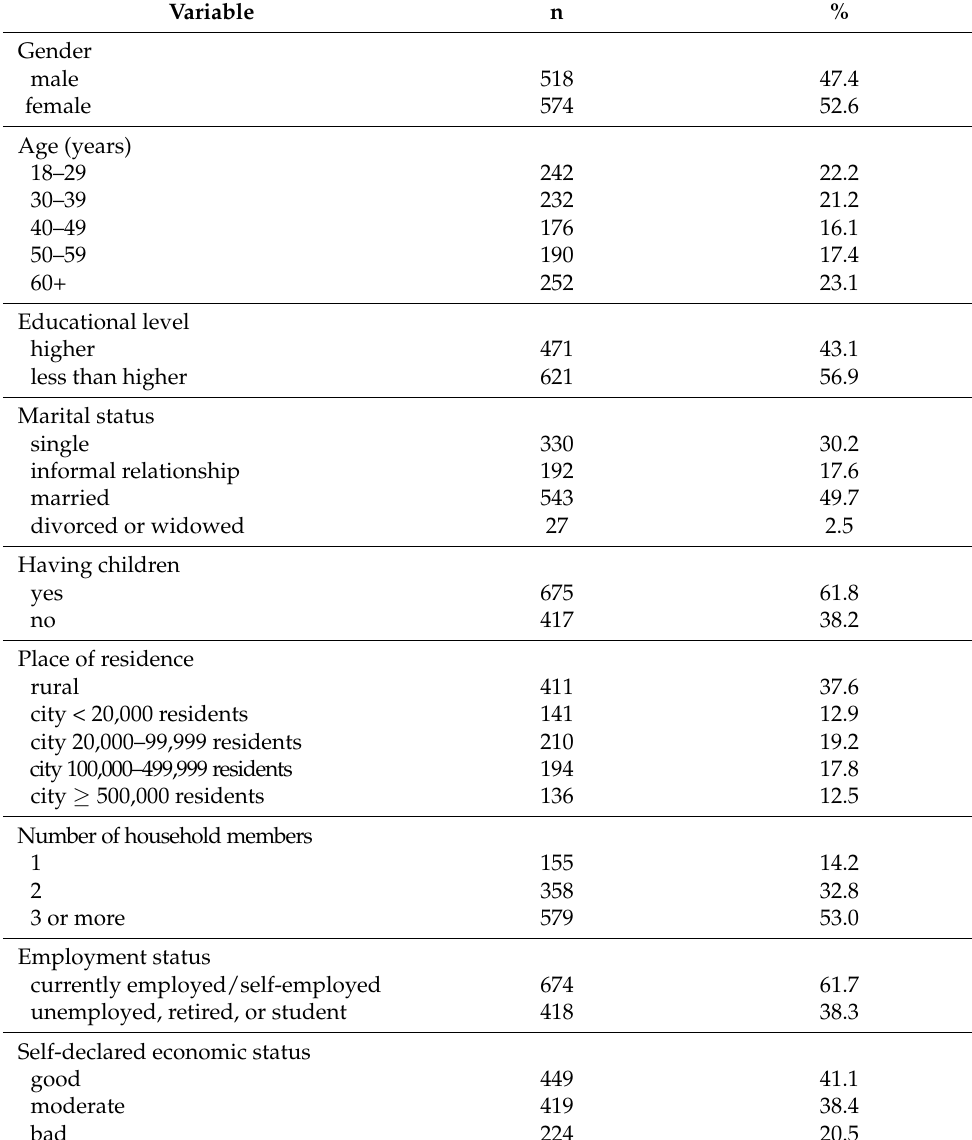
Table 1. Characteristics of the study population (n =